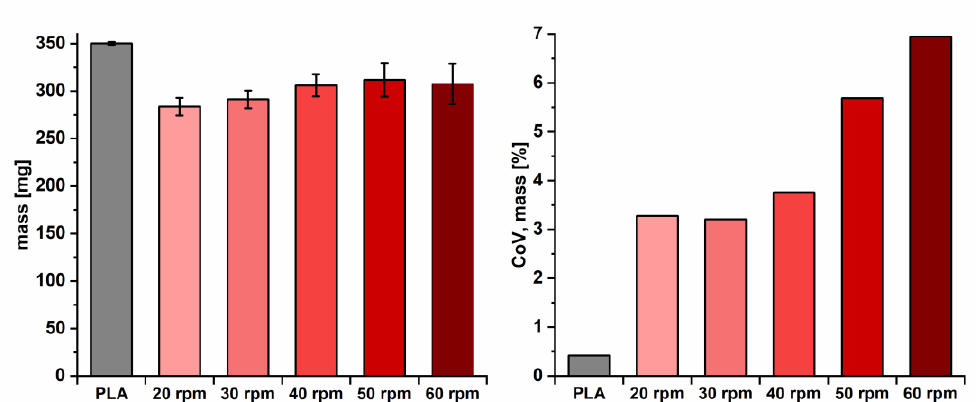
Figure 9. Mass of printed objects ( n = 20, mean ± s) of filaments produced with different screw speeds compared to commercial PLA filaments (left) and CoV mass (right).